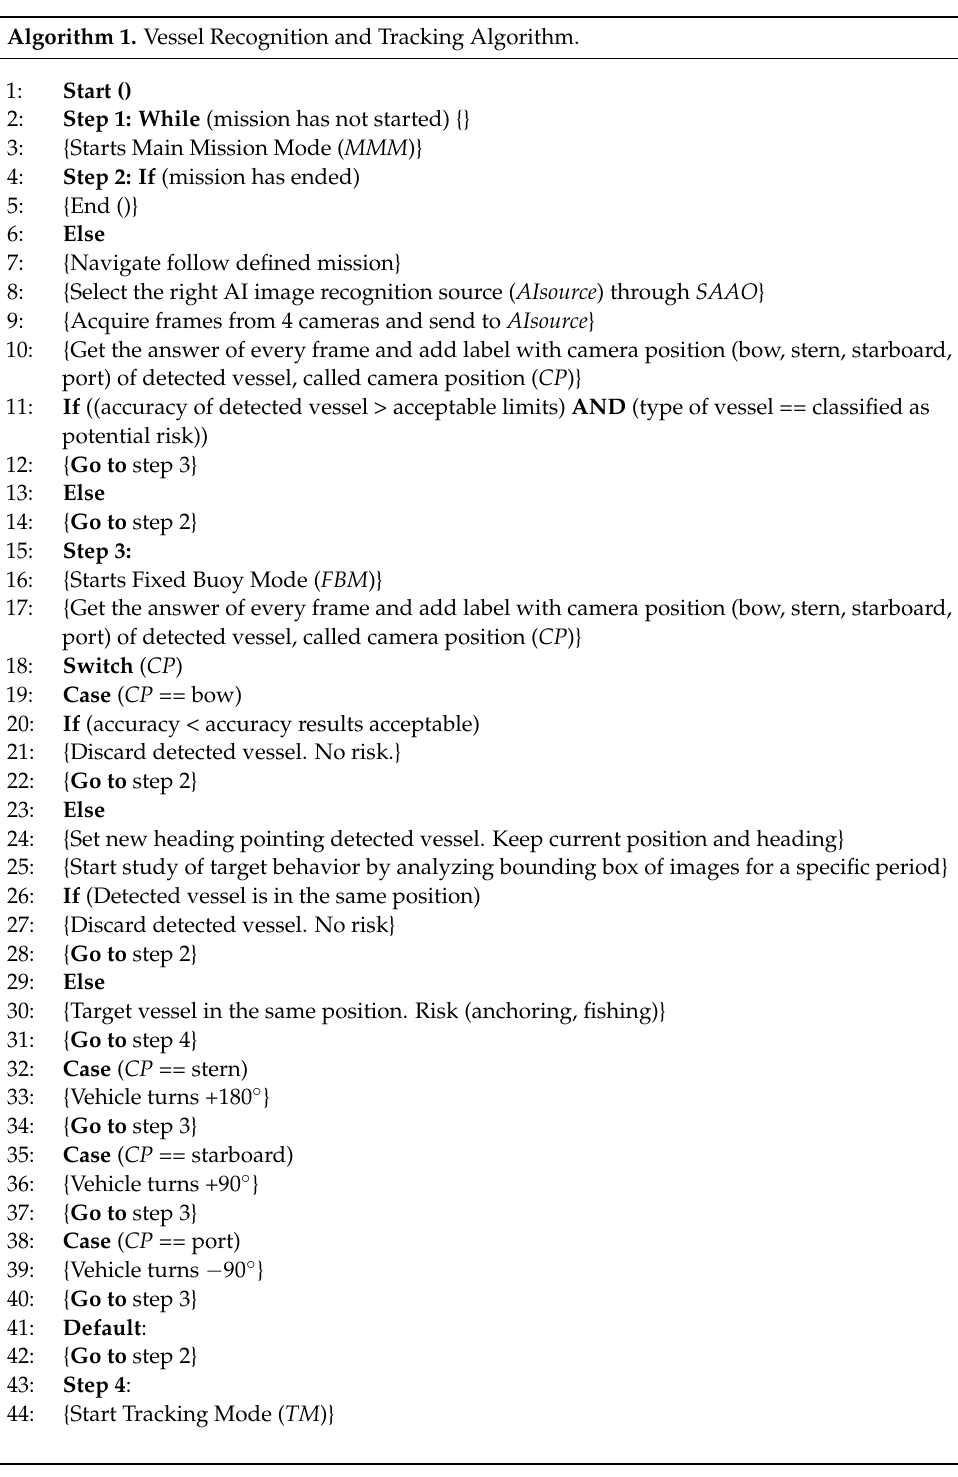
Algorithm 1. Vessel Recognition and Tracking